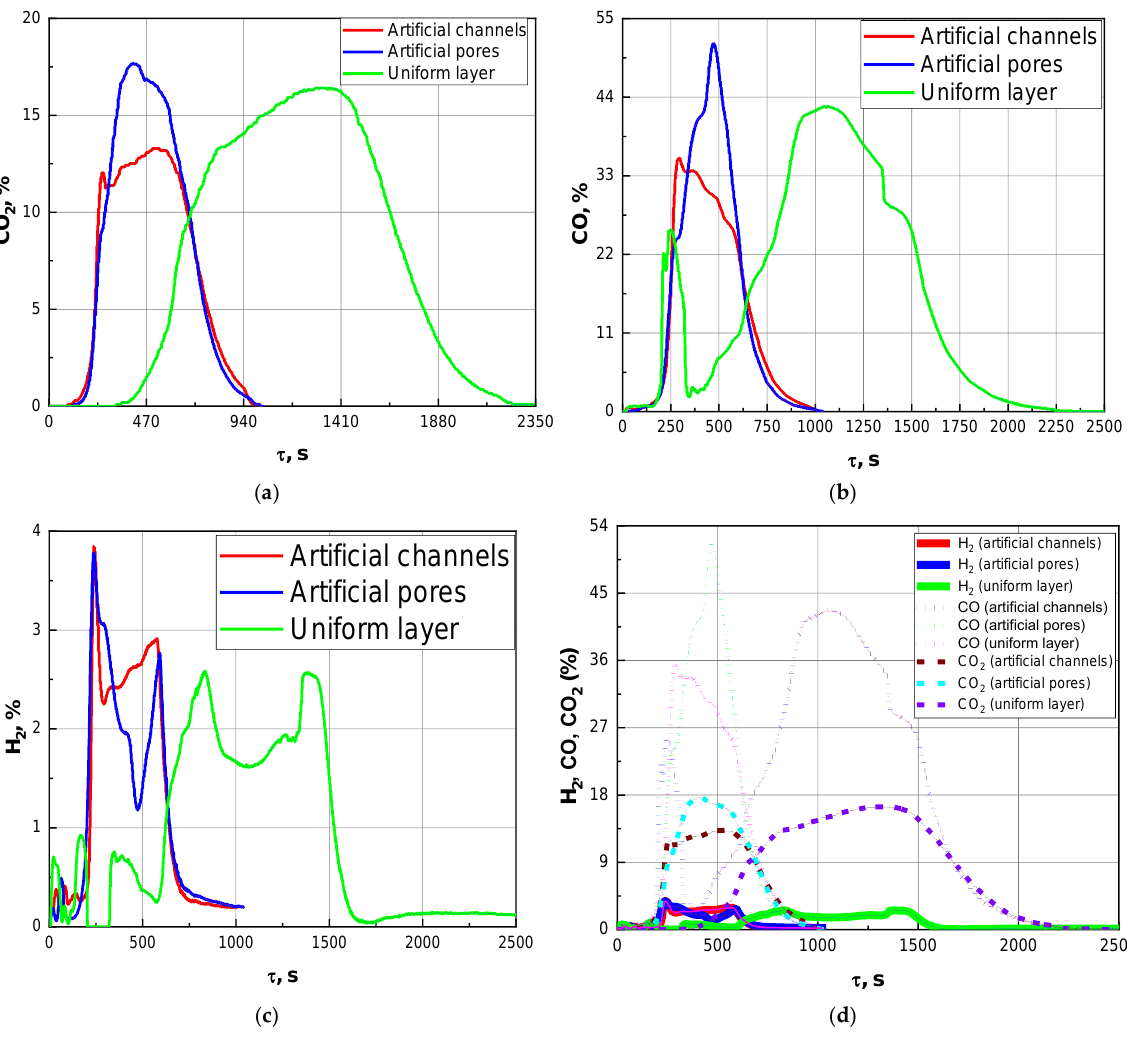
Figure 15. Trends of the concentrations of gas mixture components when varying the biomass surface structure: CO 2 ( a ); CO ( b ); H 2 ( c ); comparison of individual concentration trends ( d ).